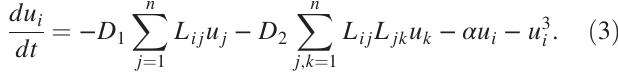
∼ N ð 0 ; 1 Þ and parameters α ¼ 90 , D − 20 , 1 ¼ i